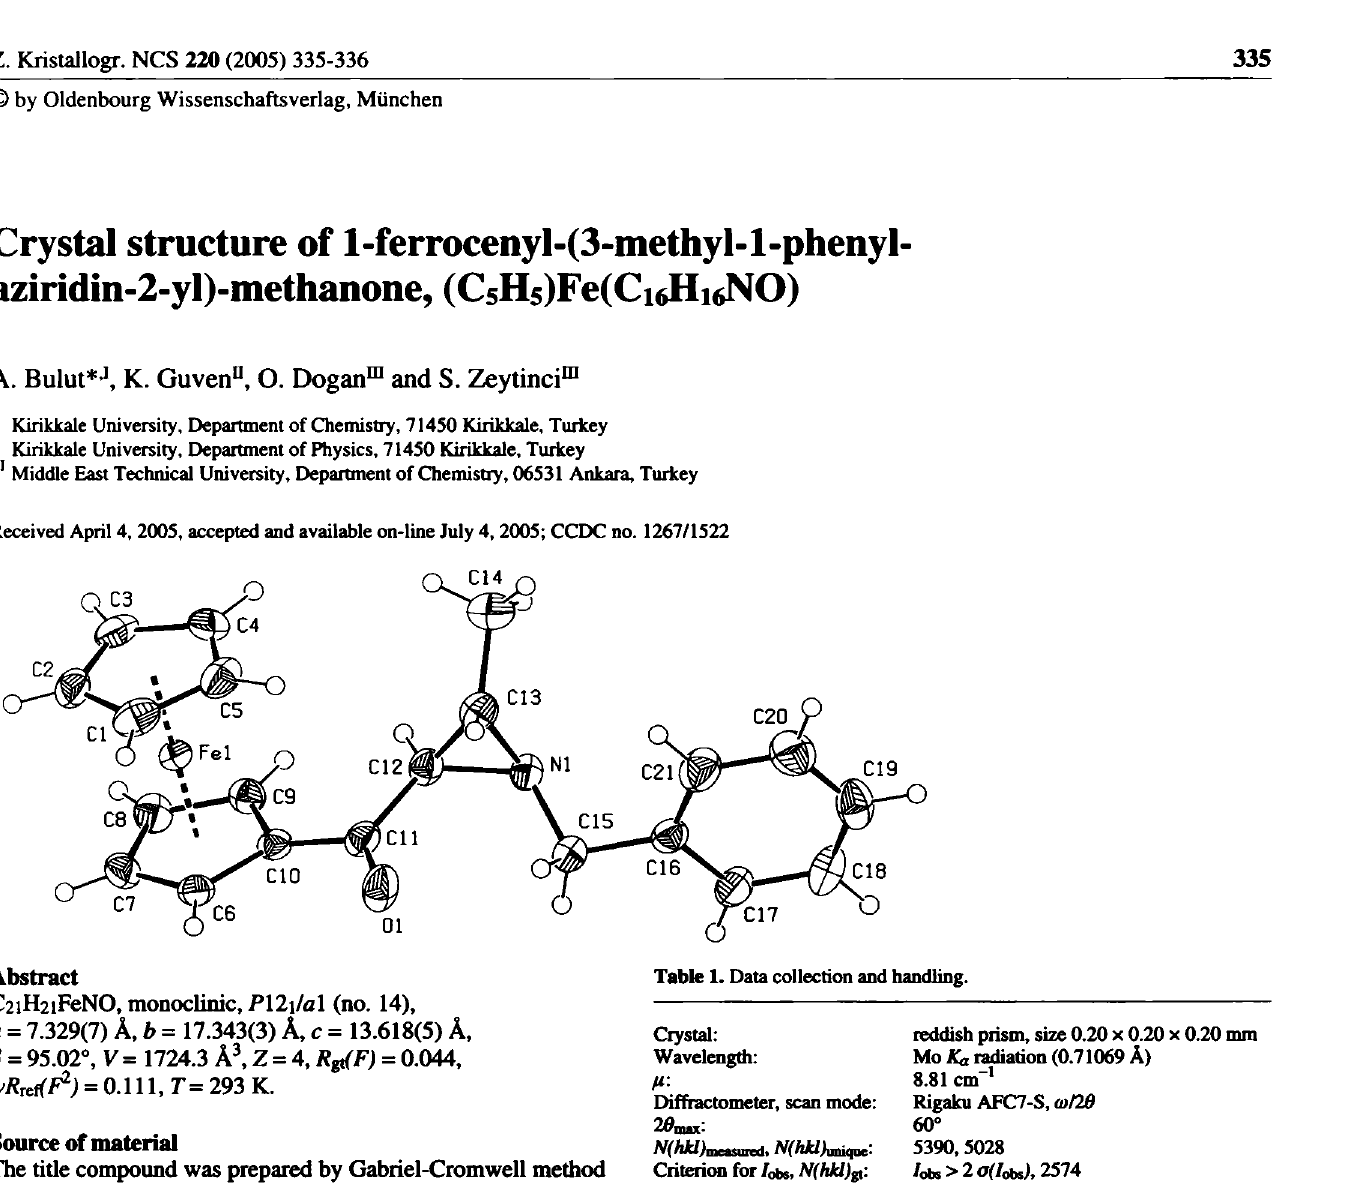
Table 2. Atomic coordinates and displacement parameters (in A 2